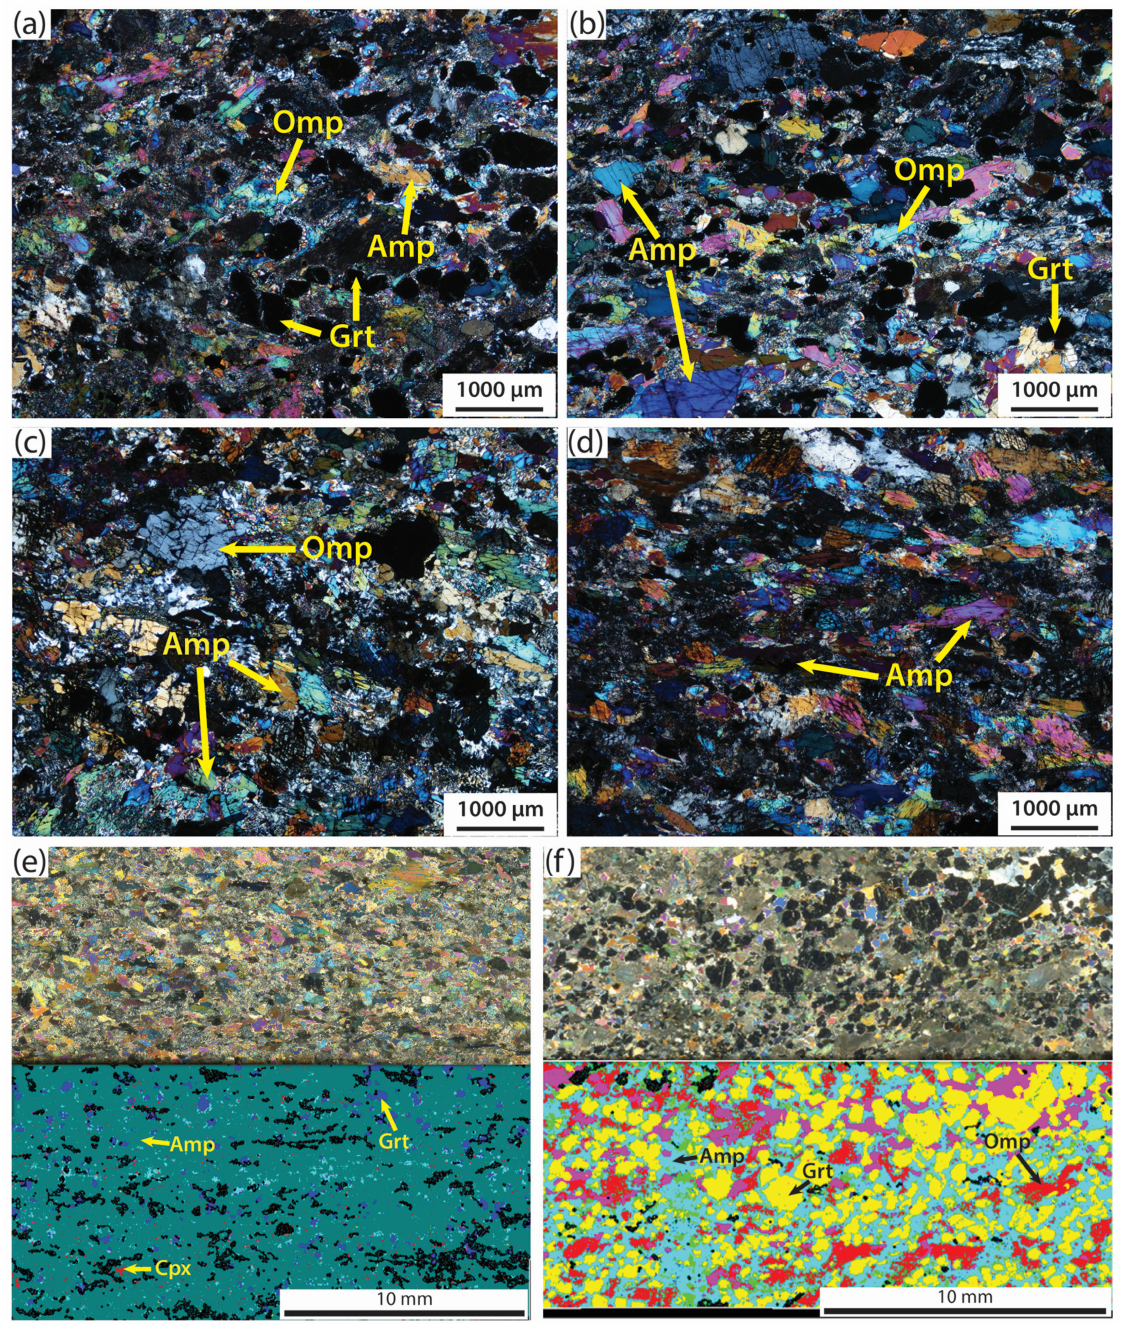
Figure 3. Photomicrograph of a thin section in the XZ plane of samples. ( a ) Sample 885, showing relatively fresh eclogite; ( b ) sample 881, showing retrograded eclogite illustrating a lack of intracrystalline deformation in amphibole; ( c ) sample 880, showing retrograded eclogite; ( d ) sample 882, the most severely retrograded eclogite showing elongated amphiboles and a well-developed foliation; ( e ) thin-section image of sample 882 in cross-polarized light (top) and EBSD phase map (bottom) (color codes: greenish blue, amphibole; blue, garnet; light blue, plagioclase; red, clinopyroxene; black, non-indexed points); and ( f ) thin-section image of sample 885 in cross-polarized light (top) and EBSD phase map (bottom) (color codes: light blue, amphibole; yellow, garnet; red, omphacite; purple, quartz; green, plagioclase; black, non-indexed points). Omp: omphacite; Amp: amphibole; Grt: garnet; Cpx: